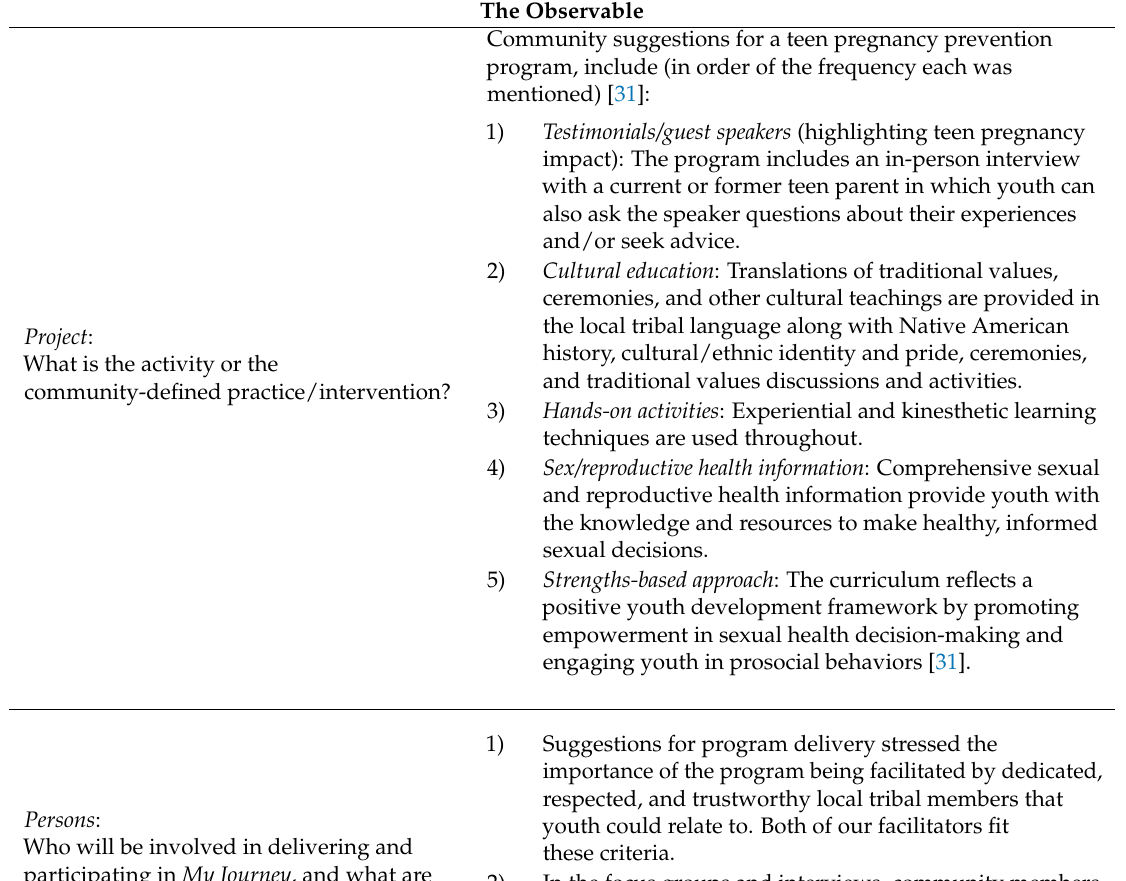
Table 3. Application of the Culture Cube Framework for My